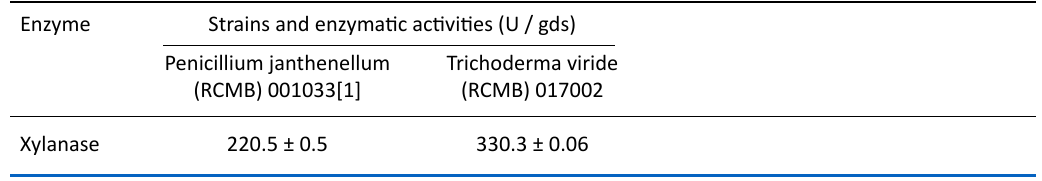
Table 3. Screening of the most potent fungal xylanase producers Enzyme Strains and enzymatic activities (U /